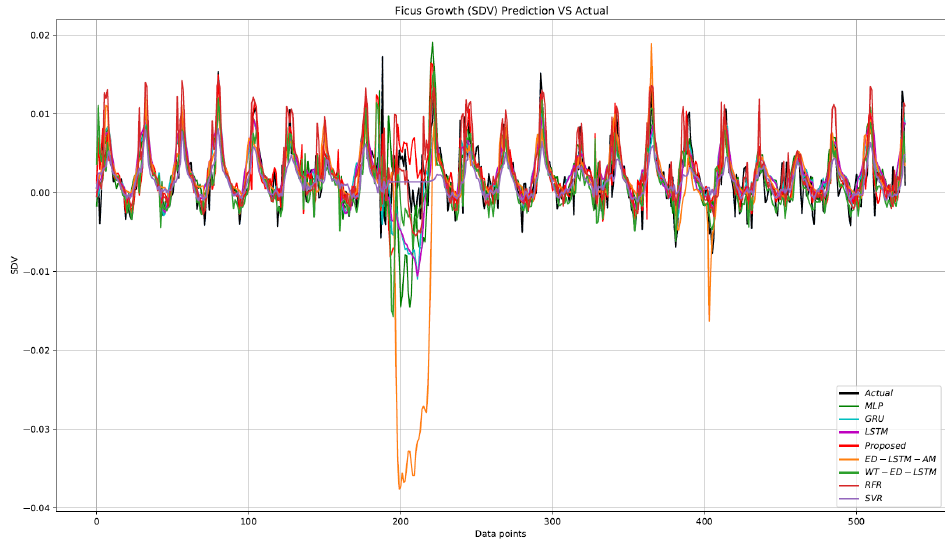
Figure 4. Performance comparison in one-step prediction (described and standard ML